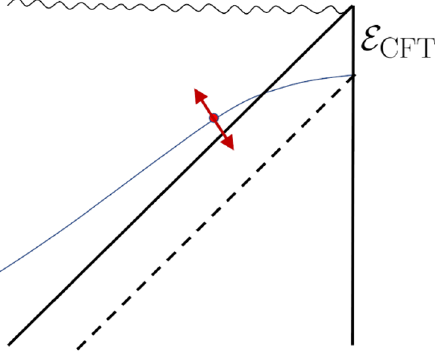
Figure 26 . To argue that a nonempty quantum extremal surface should exist for the pure state of a two-dimensional black hole, after measuring Hawking radiation, we consider Cauchy slices that asymptote to the maximal volume slice in the distant past, but which are allowed to vary elsewhere. In particular, we allow the slice to vary at infalling times approximately one scrambling time in the past of the current boundary time (this is where the non-empty extremal surface was found in [35, 36]). As shown in (cid:12)gure 25, such slices should have a local minimum in their generalized entropy near the horizon. If we vary the Cauchy slice too far into the interior of the black hole, this local minimum will become small because the area becomes small. Conversely, if we push the slice the generalized entropy. By choosing our Cauchy slice to maximize the generalized entropy of this local minima, we would necessarily (cid:12)nd a non-empty extremal surface, in a location similar to